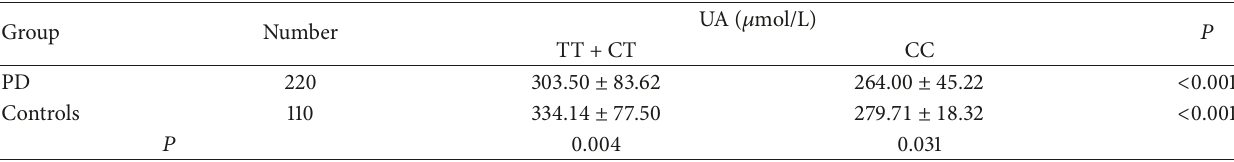
Table 4: Average serum uric acid levels in the PD and control groups. Individuals and PD patients carrying the CC genotype had lower uric acid levels as compared to those with the TT and CT